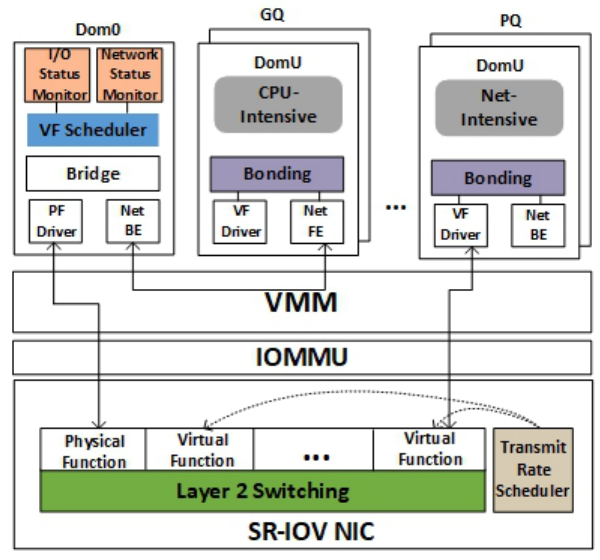
Figure 4. System